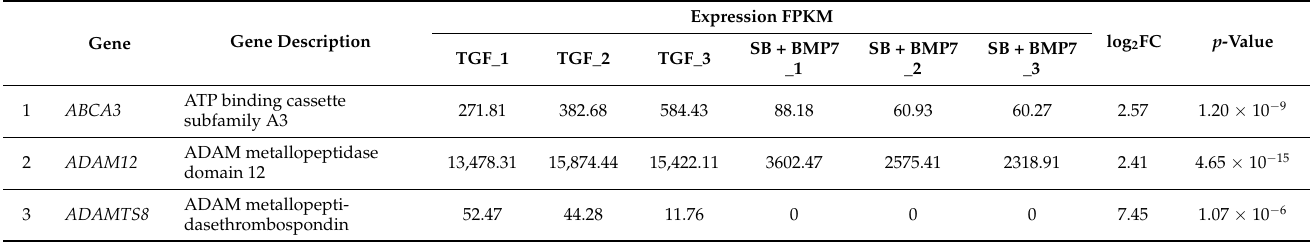
Table 2. The 142 DEGs in GO categories of ECM and membrane molecules were upregulated by TGF- β 1